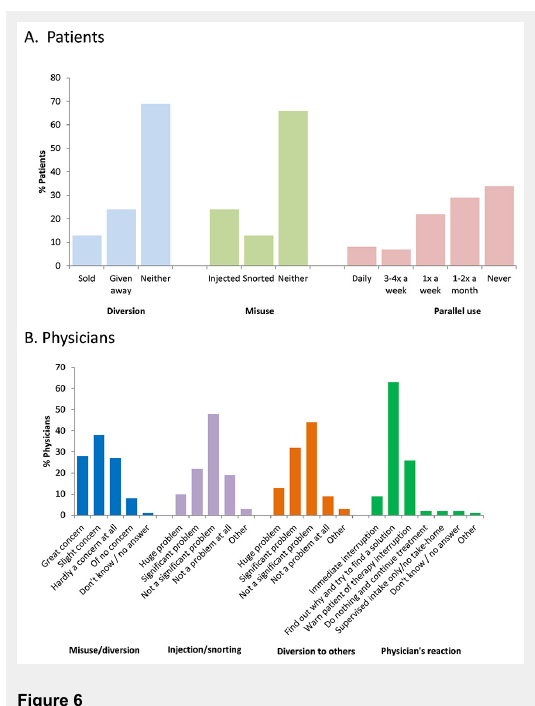
A summary of data on misuse, diversion and parallel use. A. Patient-reported data on the different ways of diversion, and misuse and the frequency of parallel consumption of illicit drugs. B. Physician-reported data on views about misuse and diversion and their reaction to these